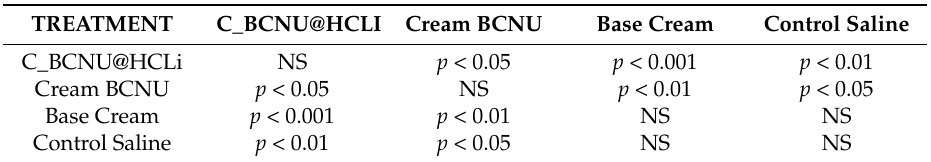
Table 6. Bcl-2 expression level: scoring and levels of significance in paired comparison of the new formulation and the control type treatments; (IHC Profiler).